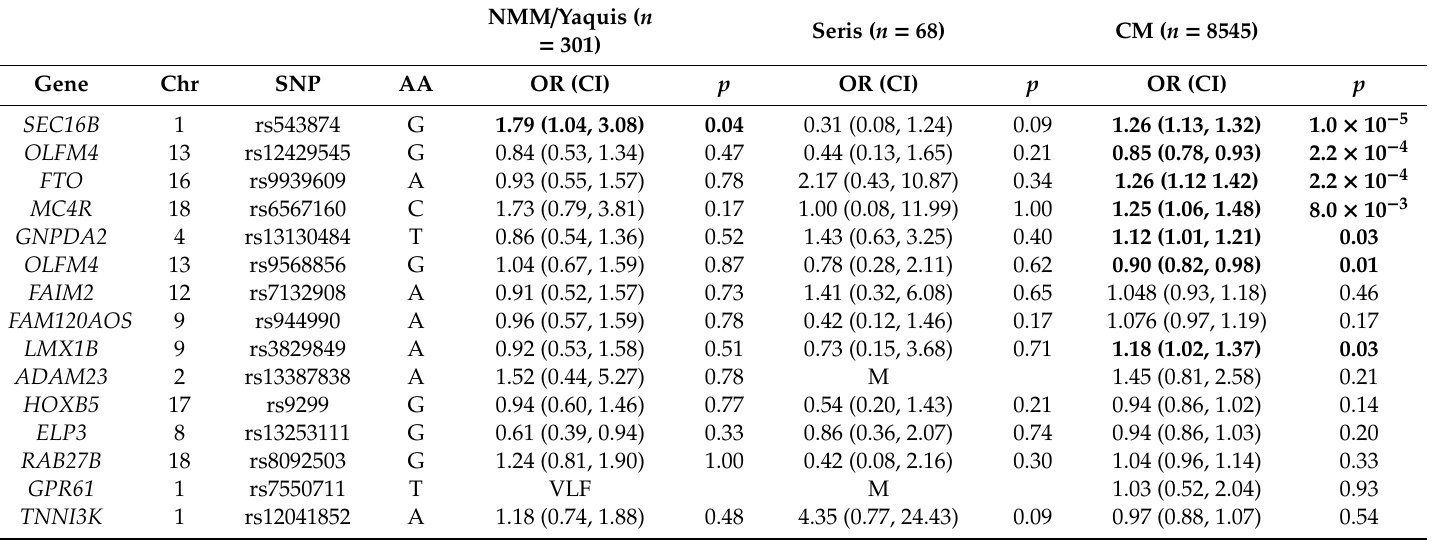
Table 3. Results of association analysis with obesity in Northern Mexican Mestizo (NMM) / Yaqui, Seri and Central Mexican (CM) children. Significant associations are shown in bold. Associated allele (AA), odds ratio (OR), confidence interval at 95% (CI), p -value ( p ), monomorphic (M) and very low frequency